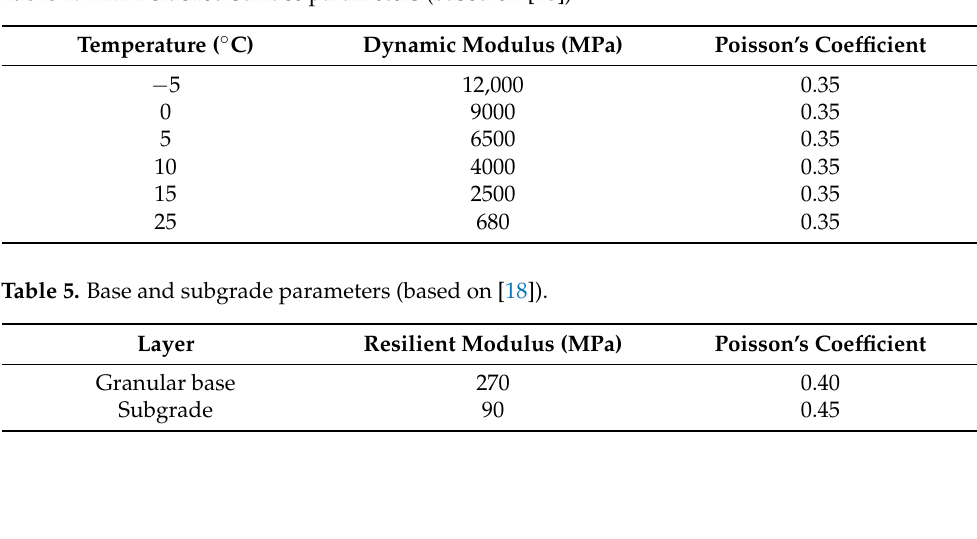
Table 4. HMA cracked surface parameters (based on [18]).